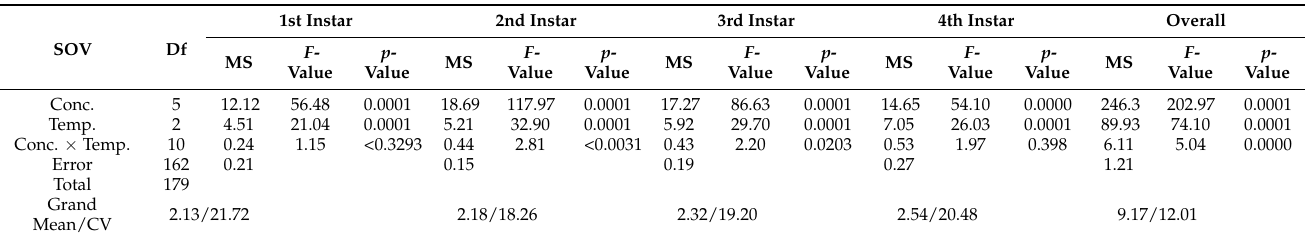
Table A2. Nymphal development time of ( M. persicae ) in relation to PeaT1 elicitor and temperature (ANOVA).